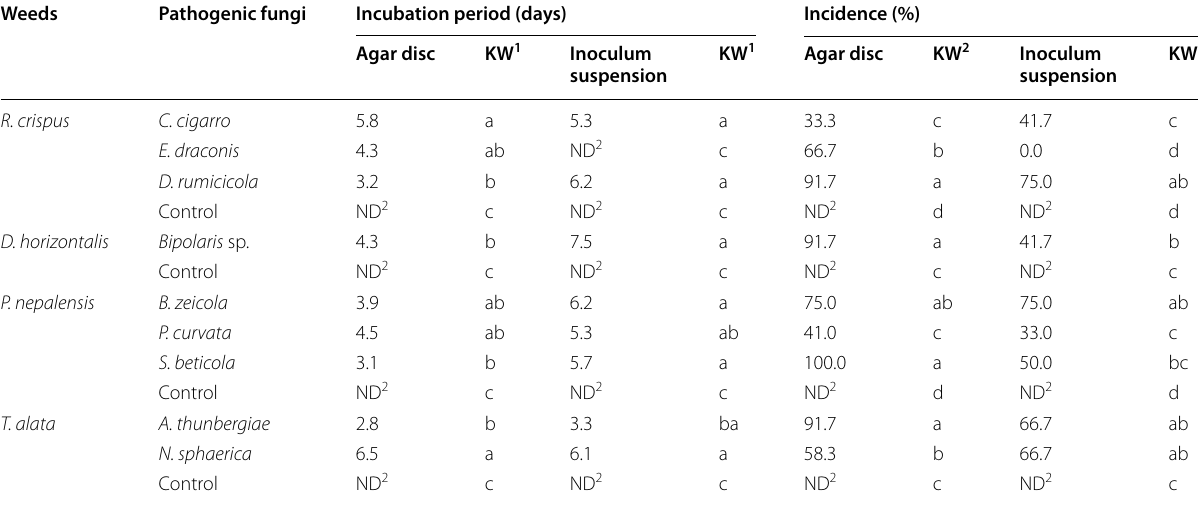
Values with the same letter do not differ statistically ( p < 0.05) 1 Kruskal-Wallis and Wilcoxon test 2 ND, Not determined